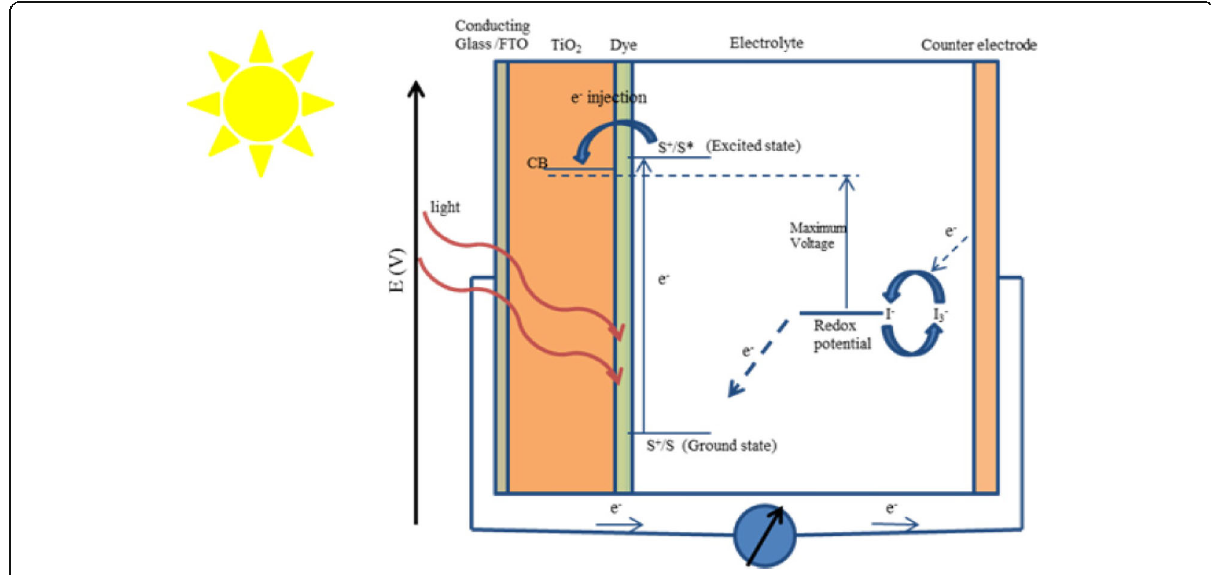
Fig. 2 Construction and working principle of the dye-sensitized nanocrystalline solar